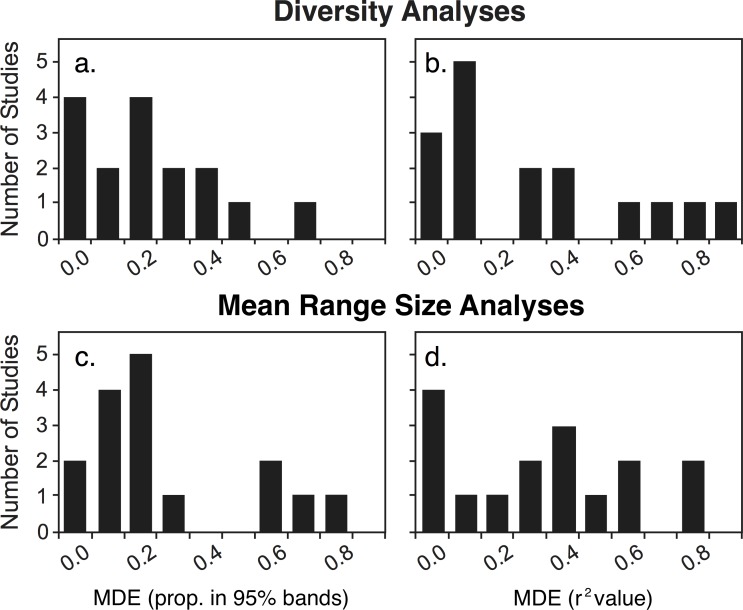
Evaluation of mid-domain effect (MDE) predictions (n = 16).MDE simulations poorly predicted diversity both in (a) the proportion of observed values falling within the 95% predictive bands (mean = 0.257 ± 0.044 (SE)) and in (b) the r2 values from linear regressions of the MDE-predicted means and observed diversity values (mean r2 = 0.354 ± 0.067). Mean range size was poorly predicted by the MDE simulations measured both by (c) the mean range sizes falling within the 95% predictive bands (mean = 0.335 ± 0.055) and by (d) linear regressions of the MDE-predicted means and observed mean range size values (mean r2 = 0.384 ± 0.059).